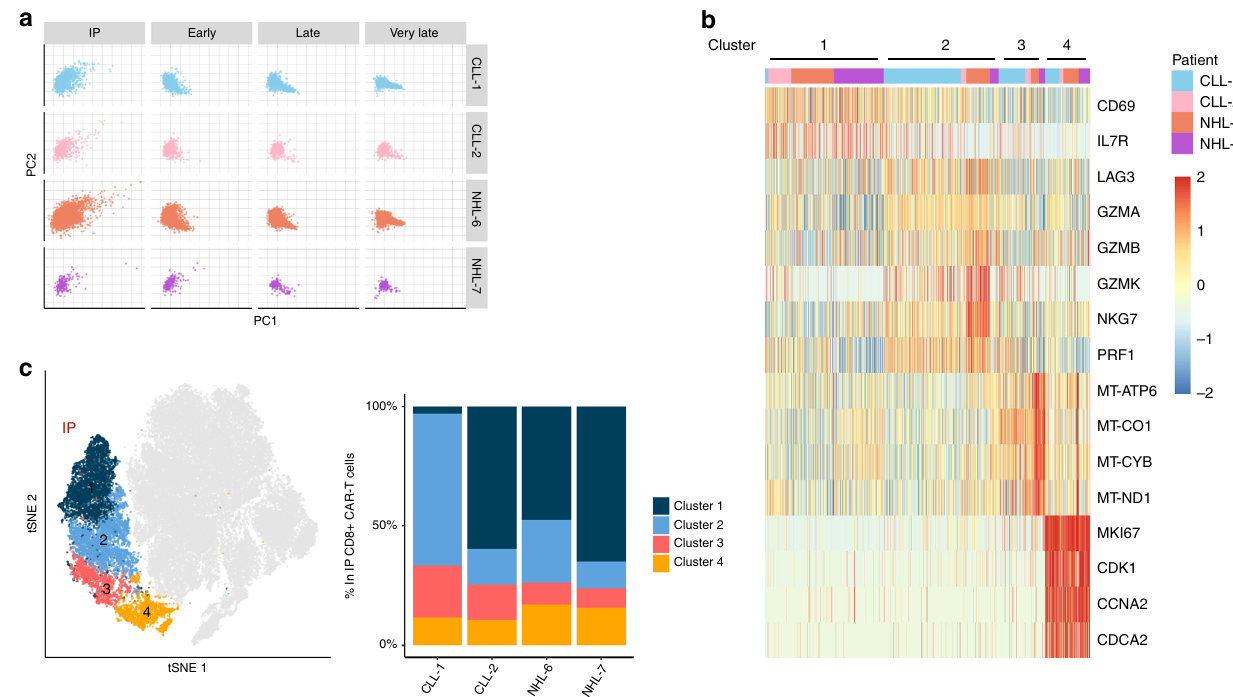
Fig. 6 CD8 + CAR-T cells in the infusion product form four transcriptionally distinct clusters. a PCA plot of single-cell gene expression residuals in CD8 + CAR-T cells isolated from the IP and blood at early, late, and very late time points. Gene expression residuals were calculated after adjusting for known sources of heterogeneity: the cellular detection rate, subject, and time point using MAST. Data were downsampled within each patient to account for differences in sample sizes between time points. b Unsupervised clustering was performed after concatenation of the scRNA-seq data across all time points and patients. Left, t-SNE plot highlighting the four transcriptionally distinct CD8 + CAR-T cell clusters identi fi ed in the IP. Each dot represents a single CD8 + CAR-T cell from the IP (colored) or from the early, late, and very late time points (gray). Right, the percentage of each identi fi ed cluster among CD8 + CAR-T cells in the IP is shown for each patient. c Heatmap displaying selected genes that are differentially expressed between clusters in the IP. Within each patient, differential gene expression analysis was performed by pairwise comparisons between clusters and only genes that were differentially expressed between clusters in all four patients were represented in the heatmap (FDR = 0.05, log2FC = 1.5). Color scale represents gene expression levels as a z